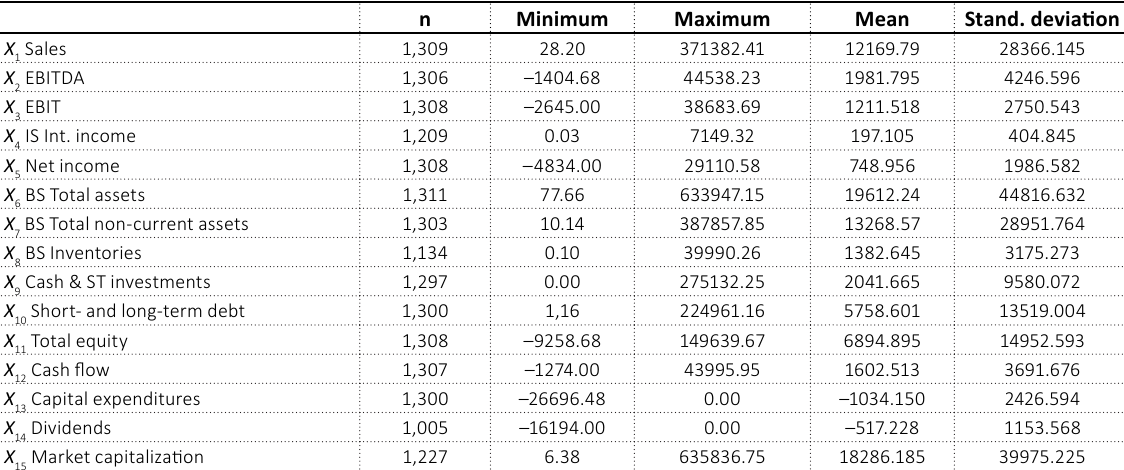
Table 5. Sample I description of the X